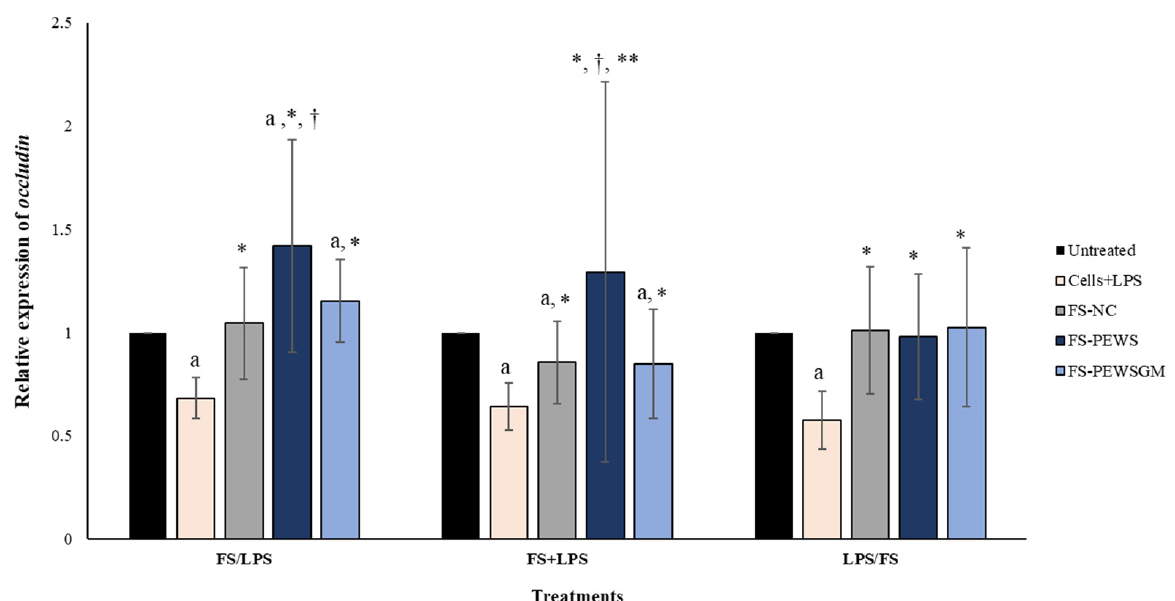
Figure 3. The effects of FSs from P. eryngii mushrooms (FS-PEWS and FS-PEWSGM) on occludin expression levels in LPS-induced Caco-2 cells. Caco-2 cells were subjected to LPS and FS treatment under three different conditions: pre incubation (FS/LPS), co-incubation (FS + LPS) and post-incubation (LPS/FS). Untreated: Caco-2 cells without any effect; FS-NC: FS of the negative control (NC: sample without additional carbon source); Cells + LPS: Caco-2 cells subjected to LPS (100 ng/mL). Data are expressed as mRNA expression (normalized with b-actin ) relative to untreated cells as mean ± SD of two independent experiments. a statistically significant for FS-PEWS or FS-PEWSGM compared to untreated cells ( p < 0.05), † statistically significant for FS-PEWS or FS-PEWSGM compared to FS-NC ( p < 0.05), * statistically significant for FS-PEWS or FS-PEWSGM compared to Cells + LPS ( p < 0.05); ** statistically significant for FS-PEWS compared to FS-PEWSGM ( p < 0.05) (Wilcoxon matched-pairs signed rank test or paired samples t -test).